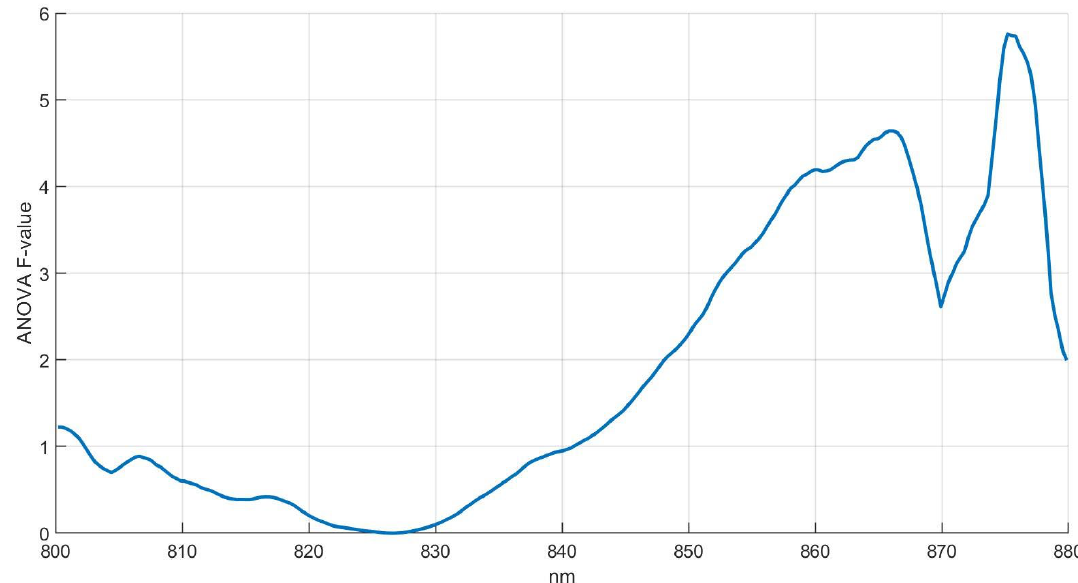
Figure 5. ANOVA F-value results from 800 to 880 nm. F-value is a ratio between two variances and a higher F-value corresponds to a significant statistical mean separation between healthy and moldy groups.